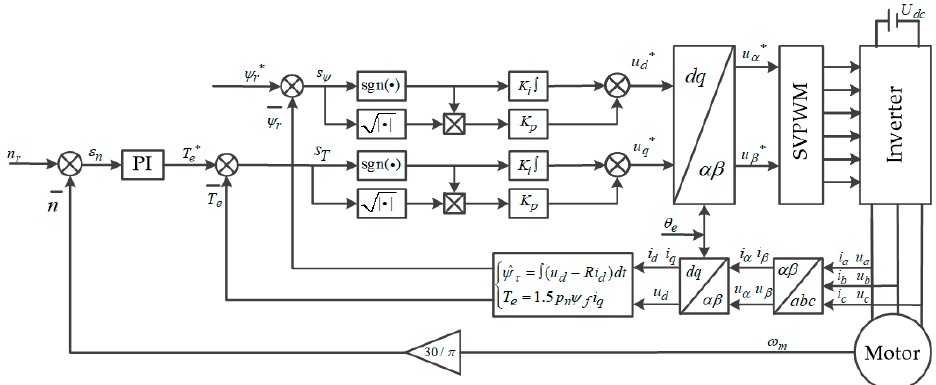
Figure 5. Logic block diagram of multi-motor ring coupling control strategy. Since the roller motor and the tension tensioning motor are connected by the con- veyor belt, the synchronous speed error between the motors has a certain tolerance. The difference between the real-time speed and the rated speed of the motor is selected as the self-following error and the synchronization error transmitted to the adjacent motor, which can reduce the influence of a single motor on the whole conveying system.